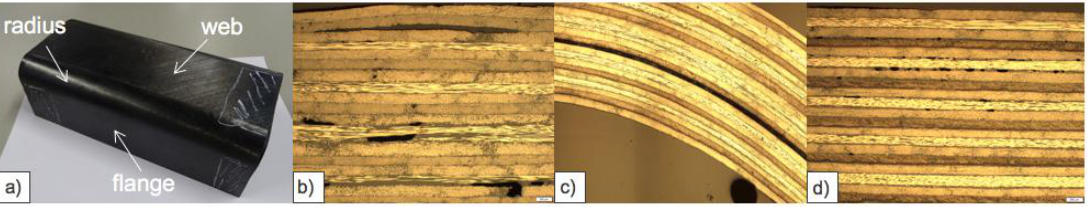
Figure 2. Typical defects in U shaped parts: ( a ) geometry of the product; ( b ) large voids in the flanges; ( c ) delamination in the web-radius; and ( d ) small porosities in multiple layers in the flanges.